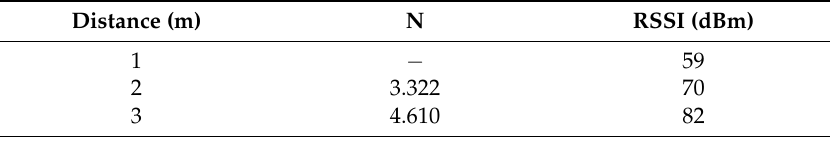
Table 1. Signal attenuation constants measured in an experimental